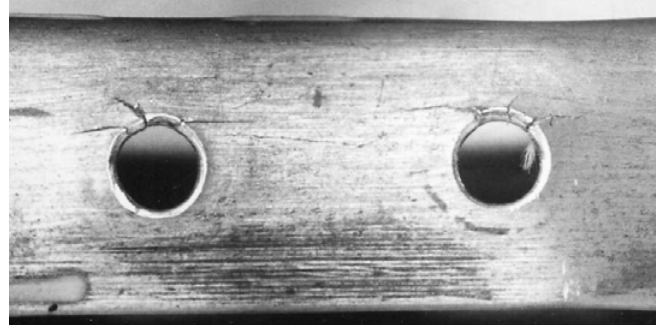
Figure 1: Cracks in undercarriage bay